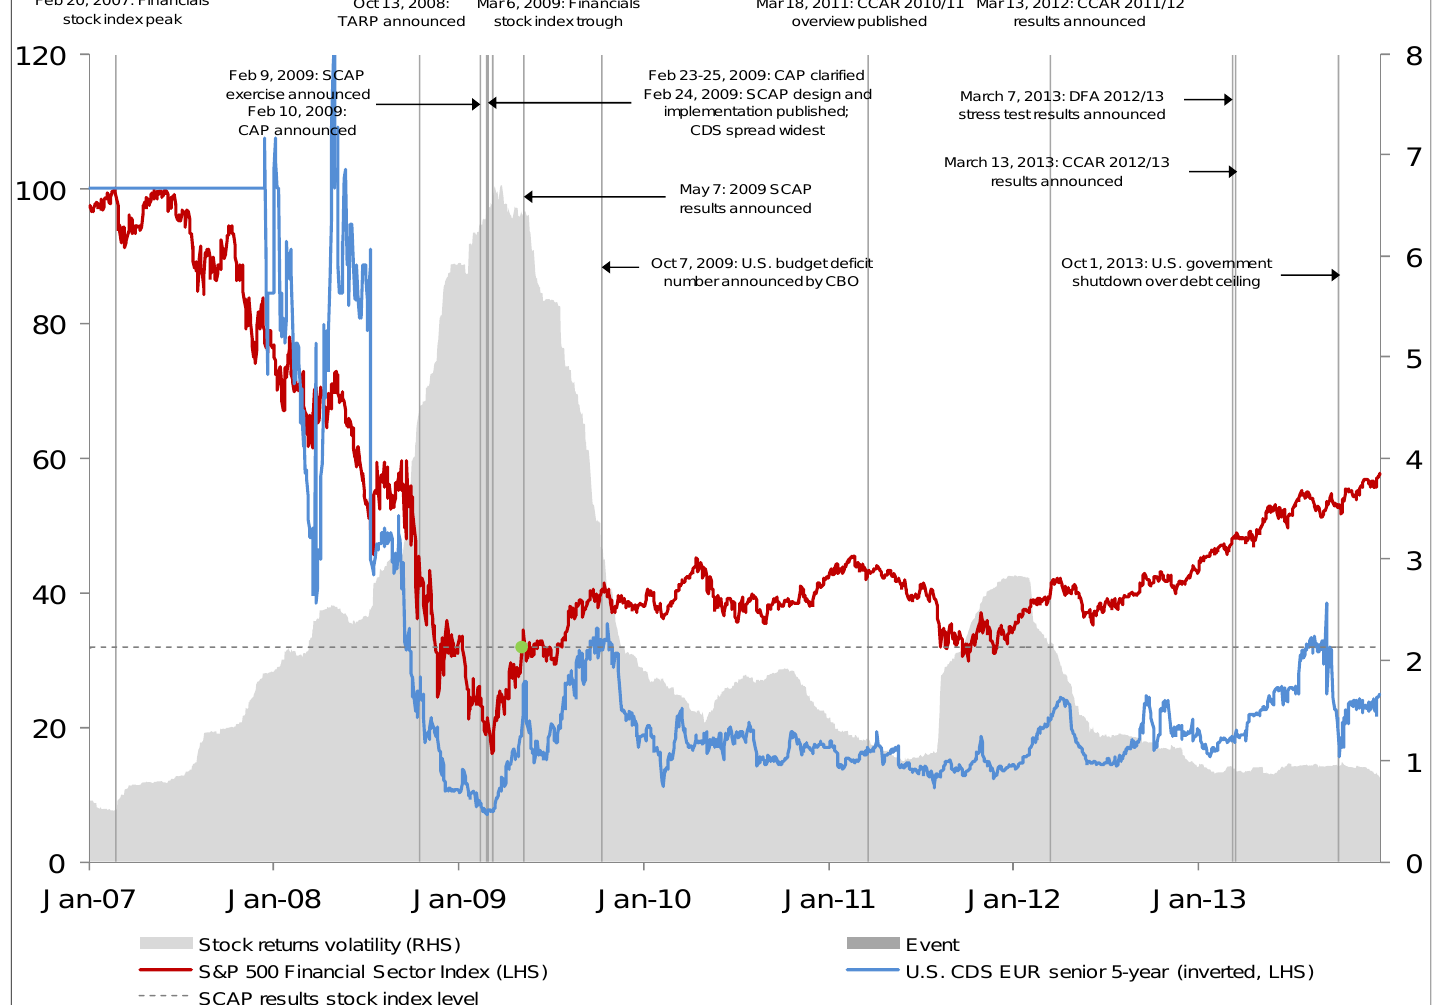
Sources: Bloomberg; Fed; various financial media; and authors’